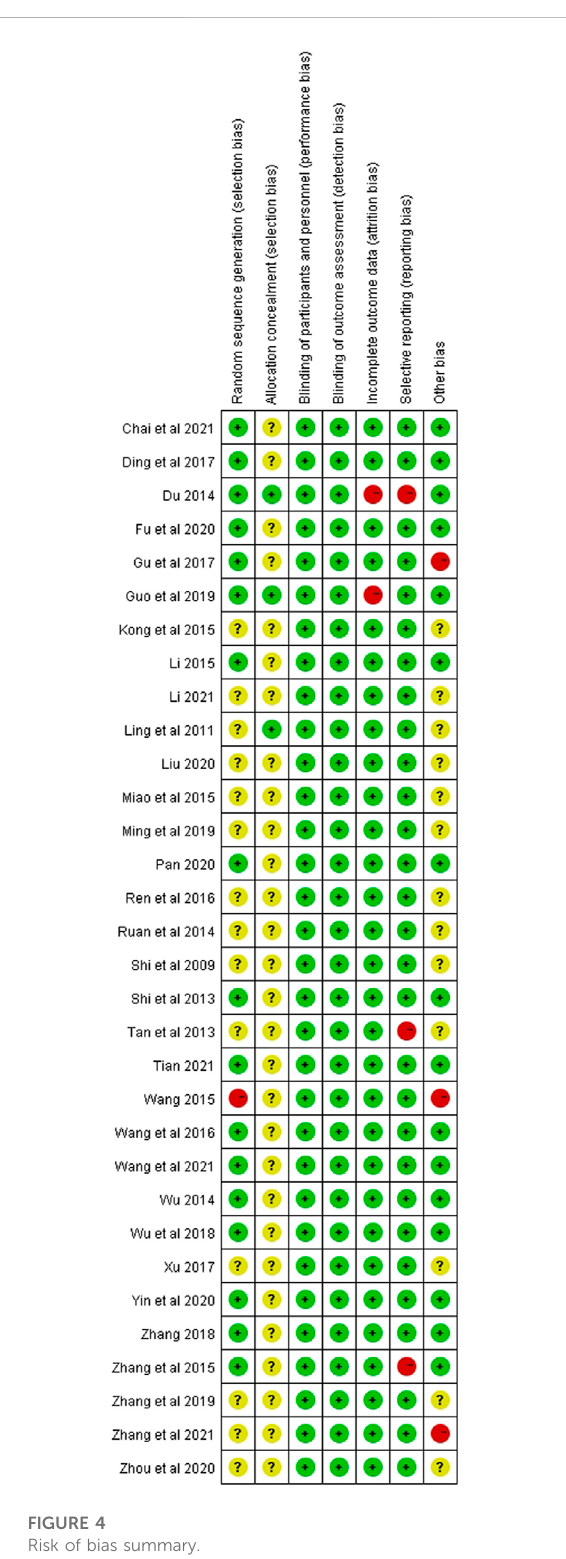
FIGURE 4 Risk of bias